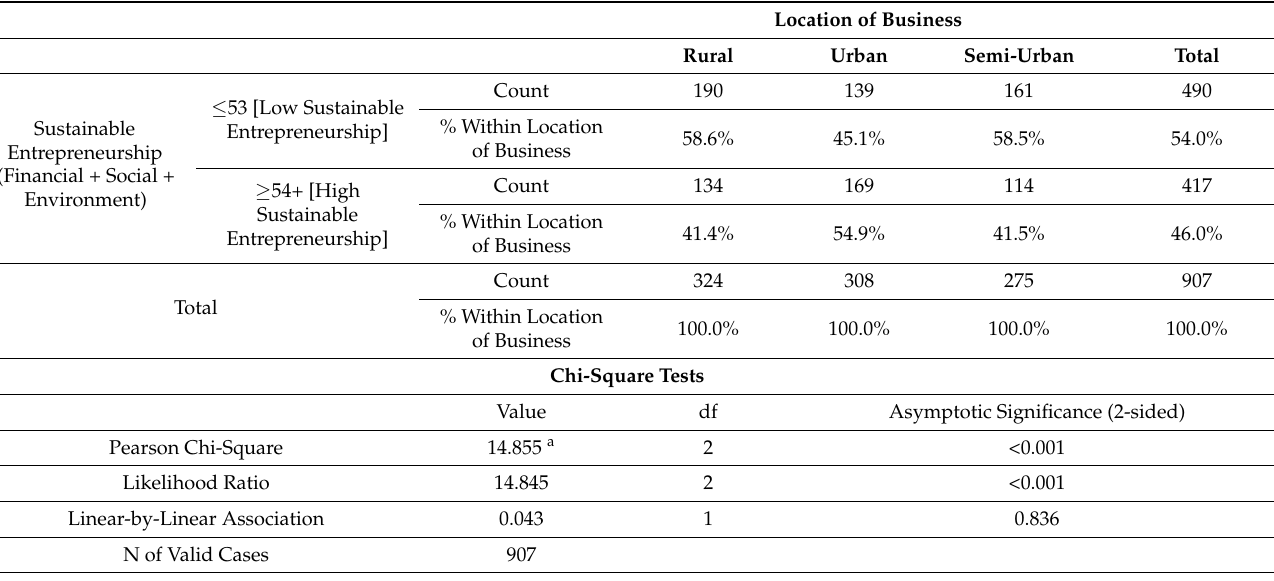
Table 5. Sustainable entrepreneurship (financial + social + environment) * location of business